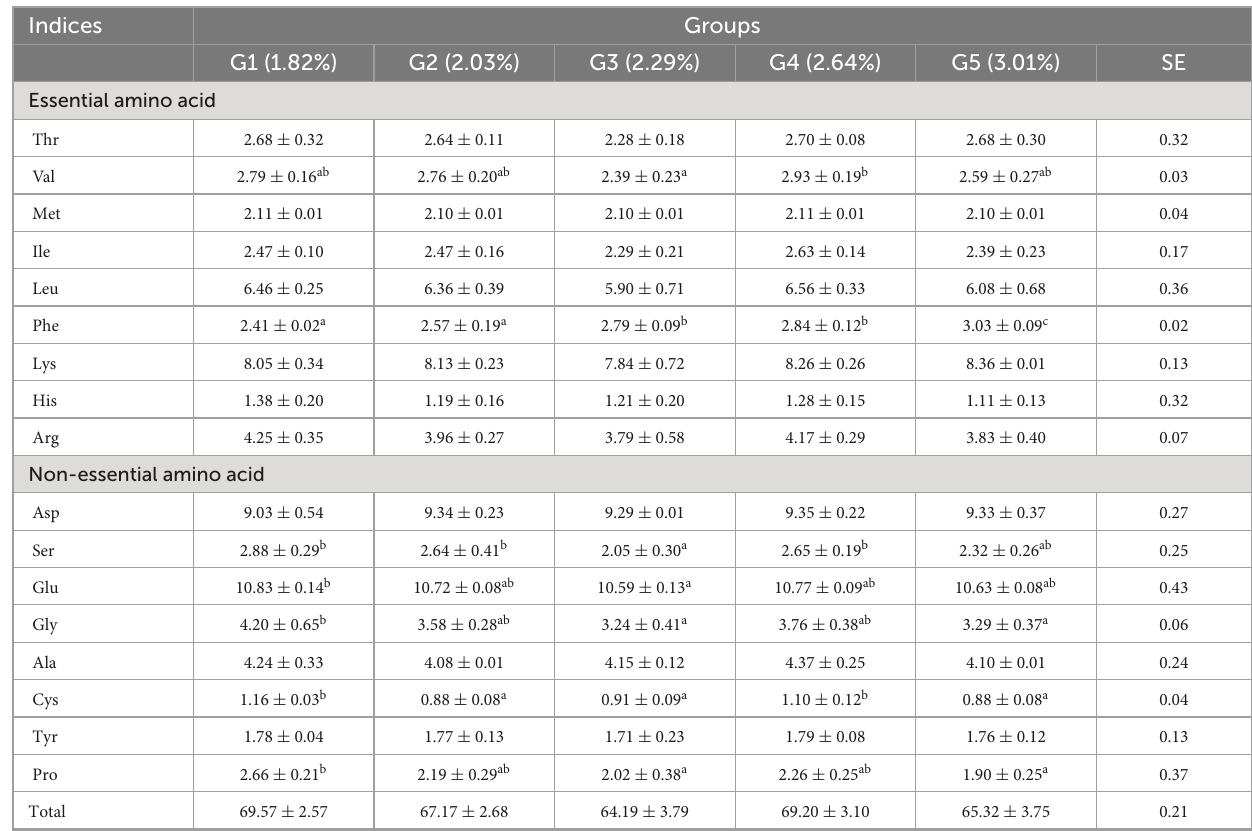
TABLE 7 Effects of dietary phenylalanine levels on the amino acid composition of whole triploid O. mykiss . Indices Groups